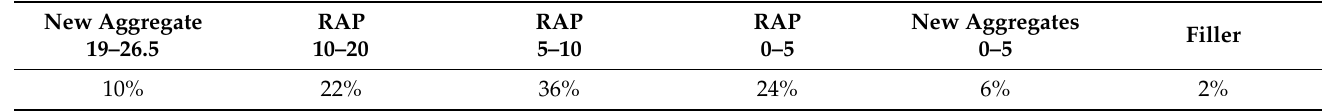
Table 3. The composition of aggregate.